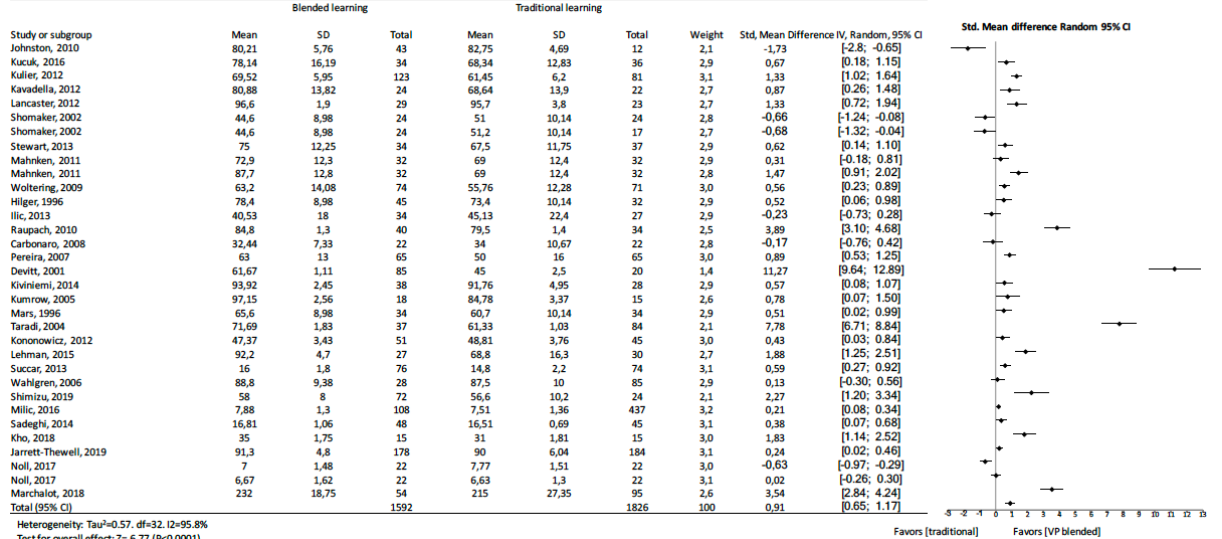
Figure 9. Forest plot of blended learning to traditional learning comparison for knowledge outcomes for medical students. df: degree of freedom; CI: confidence